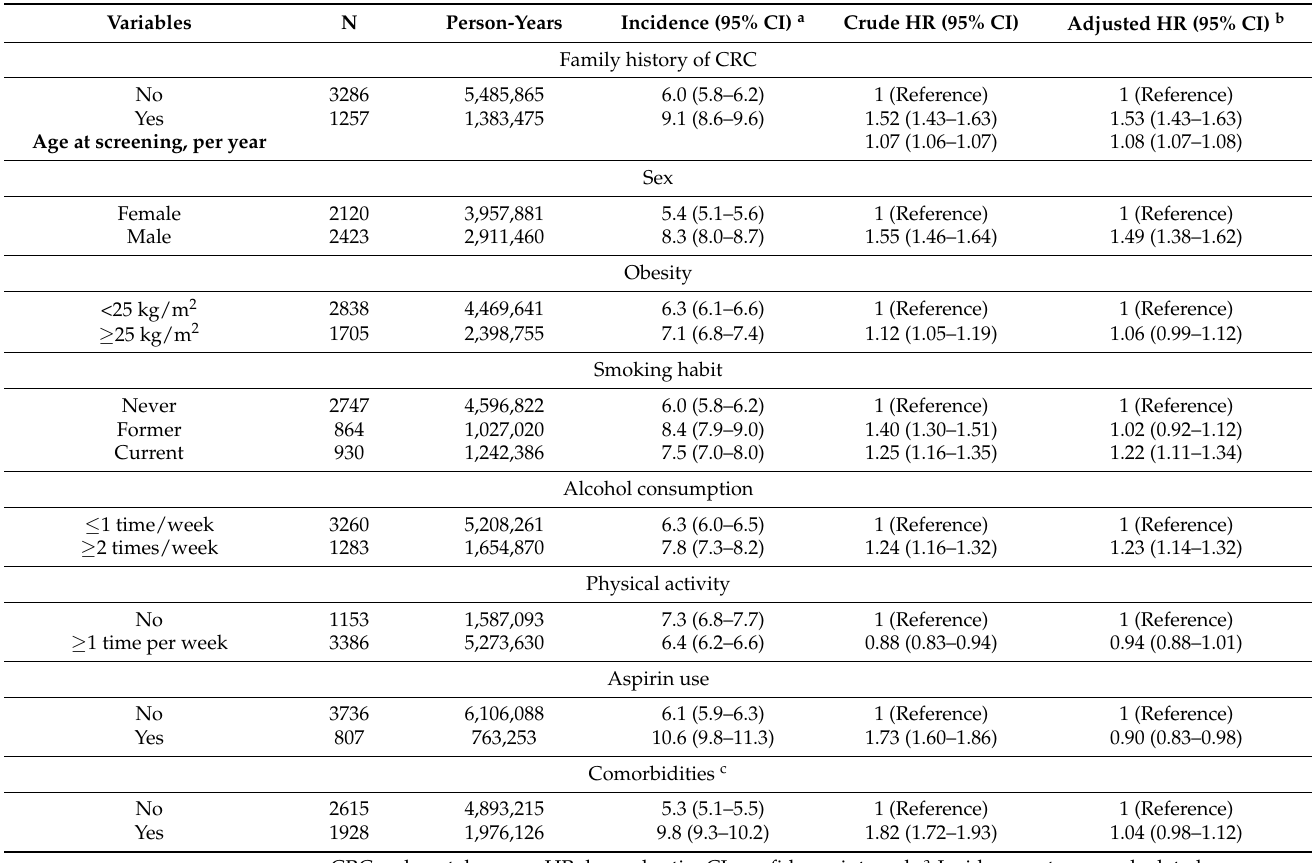
Table 2. Factors associated with risk for